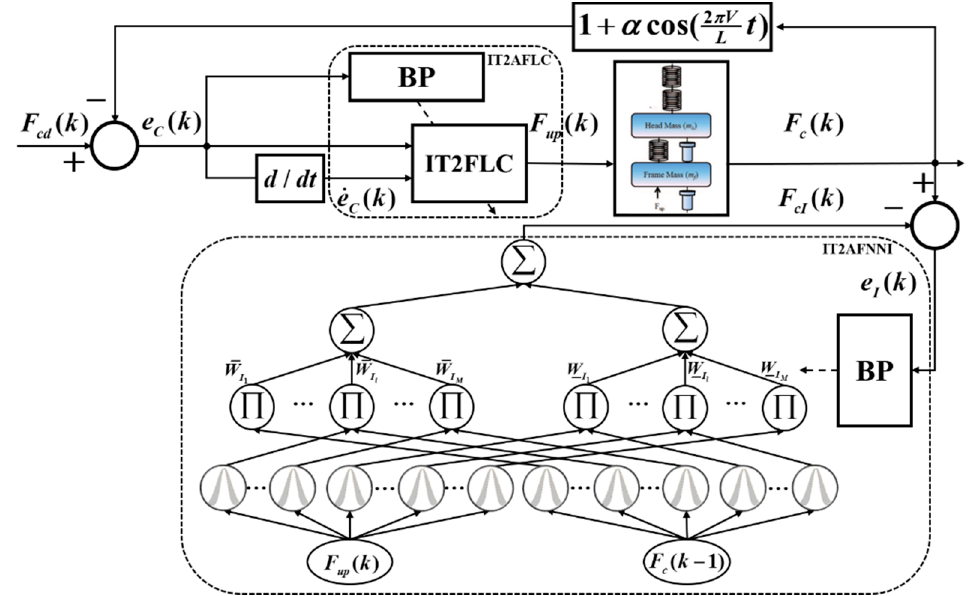
Figure 2. Block diagram of the proposed intelligent IT2AFLC scheme.